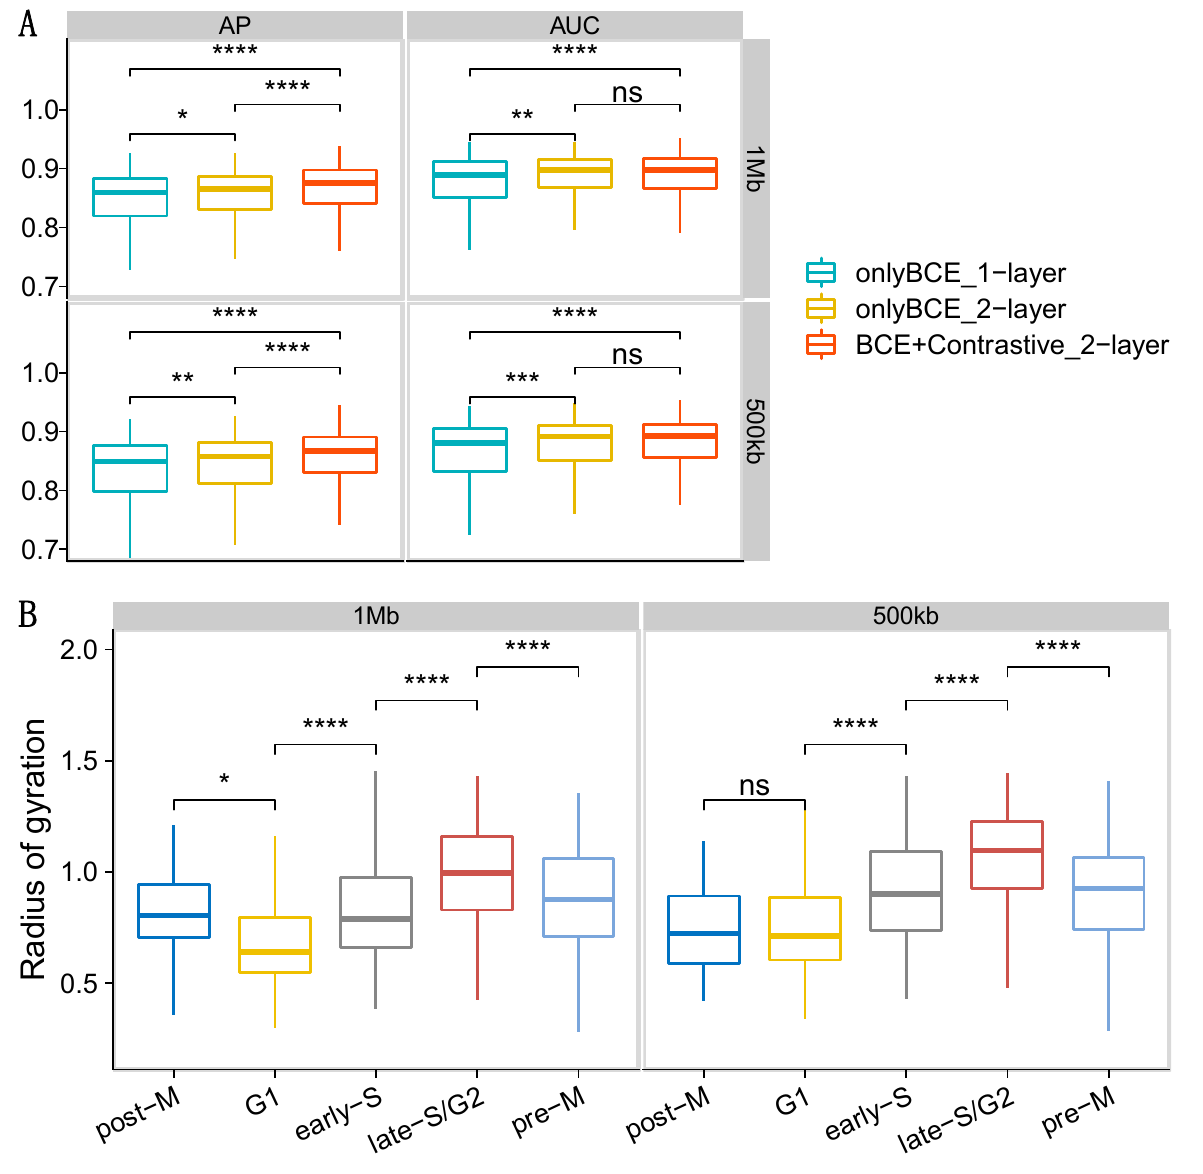
Figure 3. Results for 3D genome reconstruction on data set 4 (haploid 2i-maintained cells) at 1 Mb and 500 kb resolutions for scHiCEmbed with raw single-cell Hi-C as input. ( A ) graph network evaluations using AP and AUC for three different combinations of loss function and number of layers. ( B ) The radius of gyration of our reconstructed 3D genome structures at different cell stages. ns: p ‐ value > 0.05, *: p ‐ value (cid:3409) 0.05, **: p ‐ value (cid:3409) 0.01, ***: p ‐ value (cid:3409) 0.001, ****: p ‐ value (cid:3409) 0.0001.